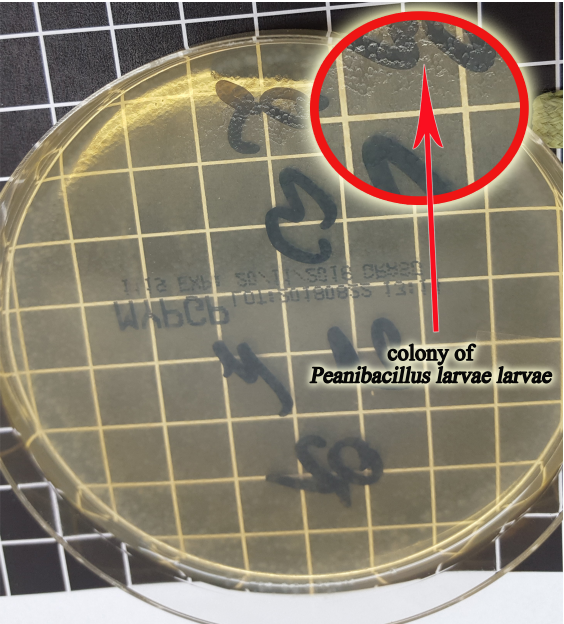
Figure 4. The Petri dish with MYPGP media (which contains yeast extract, Mueller-Hinton broth, glucose, K 2 HPO 4 , sodium pyruvate, and agar) with visible fine, transparent, and slimy colonies of the P.l.larvae; 6-day culture.